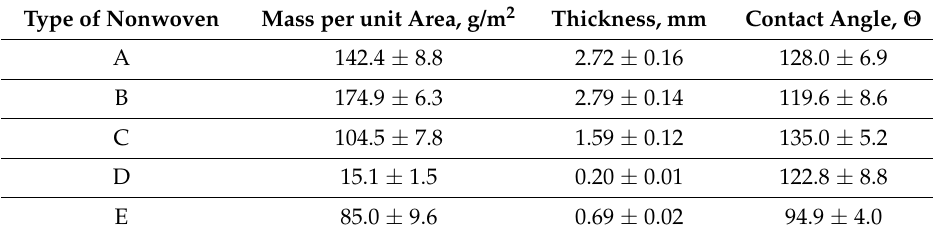
Table 3. Structural parameters and contact angle of